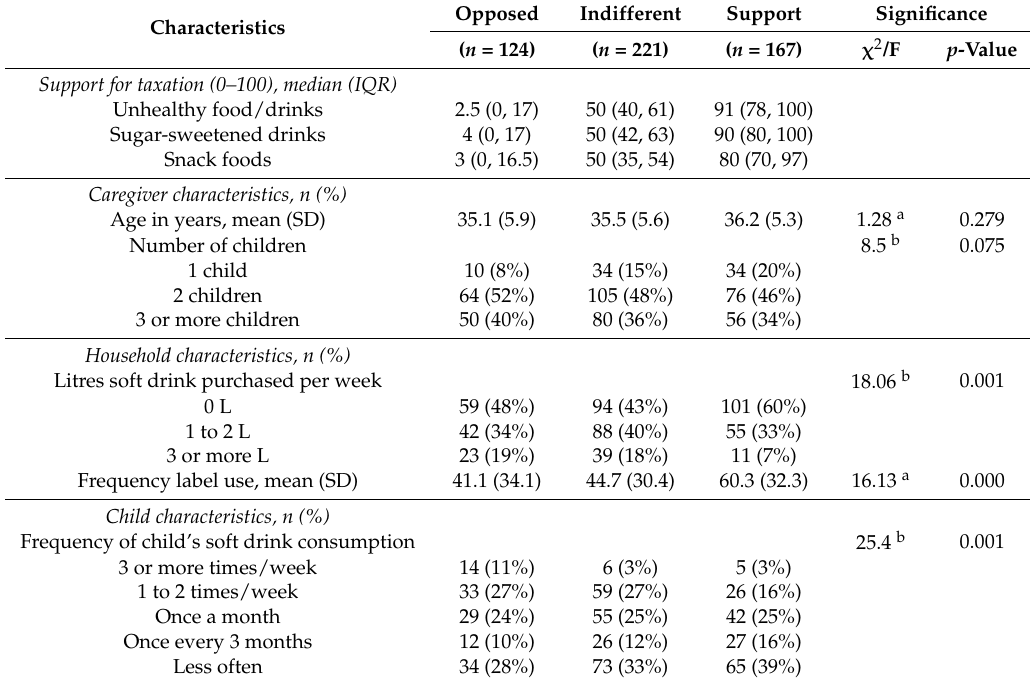
Table 2. Characteristics of the three identified clusters with respect to approval of